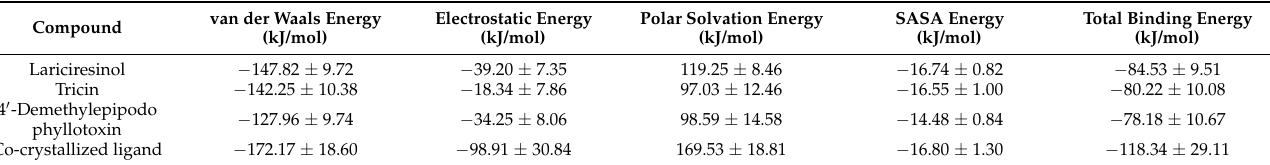
Figure 8. The ligand–protein interaction profiles after the simulation. ( A ) Co-crystallized ligand, ( B ) Lariciresinol, ( C ) Tricin, and ( D ) 4 ′ -Demethylepipodophyllotoxin. The blue lines represent hydrogen bonding interactions and the gray sticks represent hydrophobic interactions. Table 3. MM/PBSA binding free energy between three hits and the co-crystallized ligand with